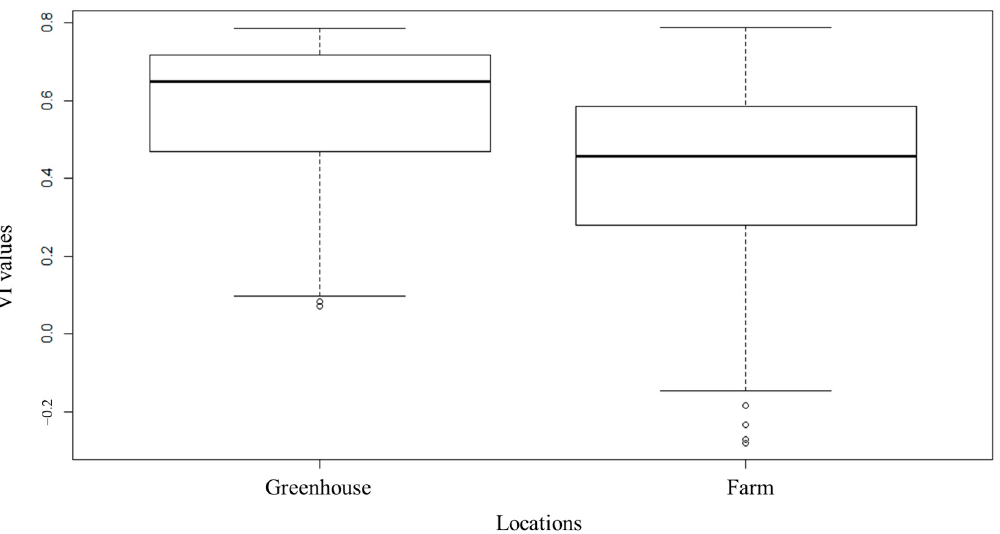
Figure 3. Box plots for VI values in the greenhouse and farm field, which do not show a statistically significant difference by t -test ( p > 0.05).